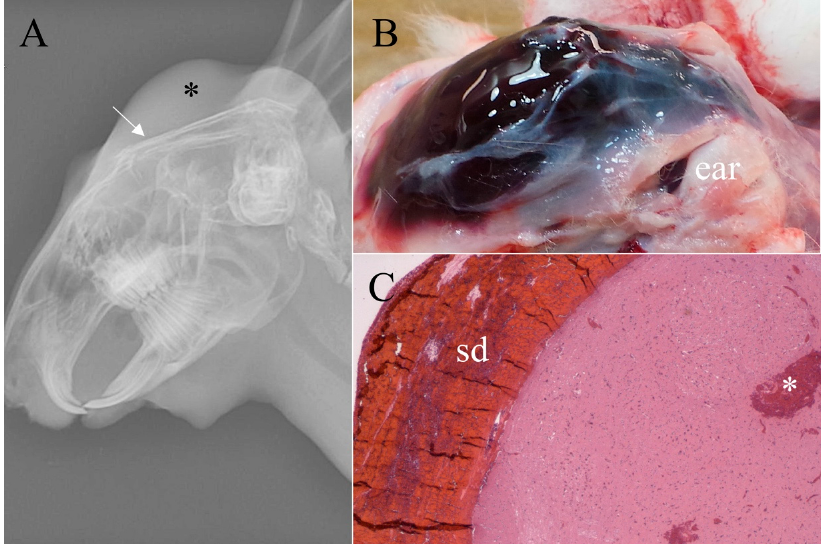
Figure 3. Eight week-old grower rabbit euthanized with the non-penetrating captive bolt device. ( A ) Survey radiograph demonstrating fractured and depressed cranium (arrow) and marked subcutaneous swelling and hemorrhage (*); ( B ) Skin reflected to demonstrate marked subcutaneous hemorrhage completely covering the area from the eyes to the base of the skull (gross score of 4/4); ( C ) Photomicrograph of midbrain demonstrating marked subdural hemorrhage (sd) (histologic score of 4/4) and moderate parenchymal hemorrhage (*) (histologic score of 3/4) (H & E, ×20).